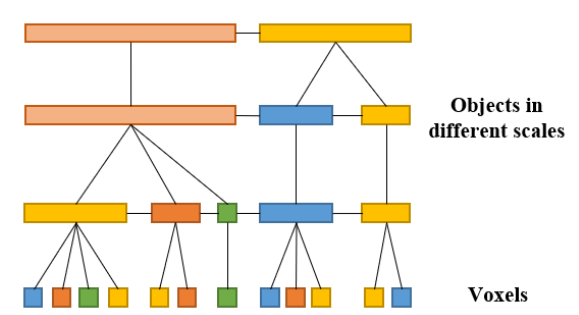
Figure 2. Semantic object network built by FNEA (modified after Baatz and Schape